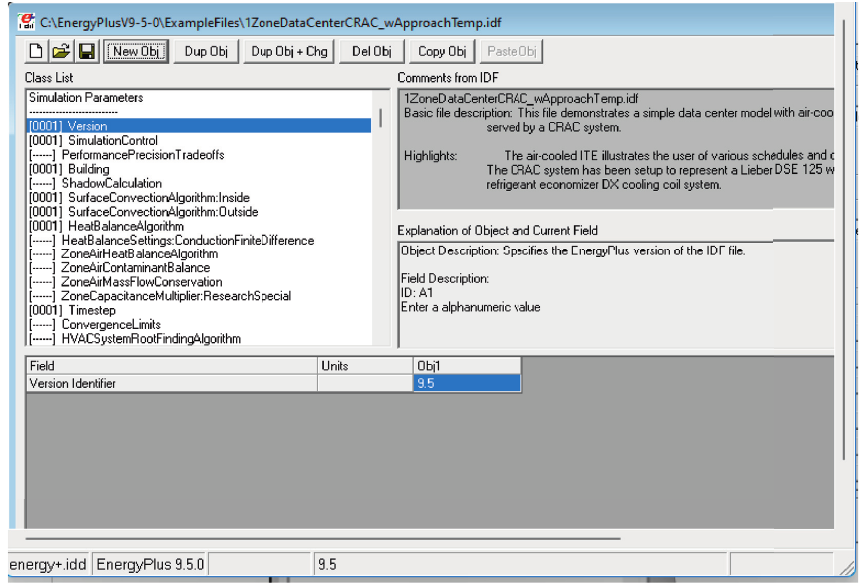
Figure 4: User interface of Energy Plus for location mapping.